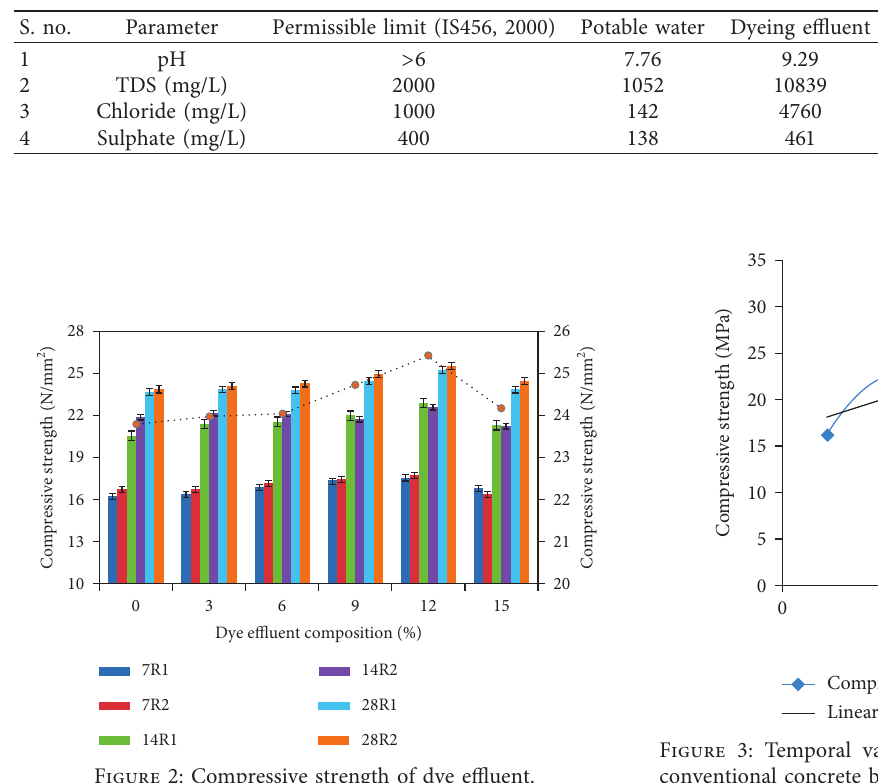
Table 3: Chemical composition of potable water and treated effluent.